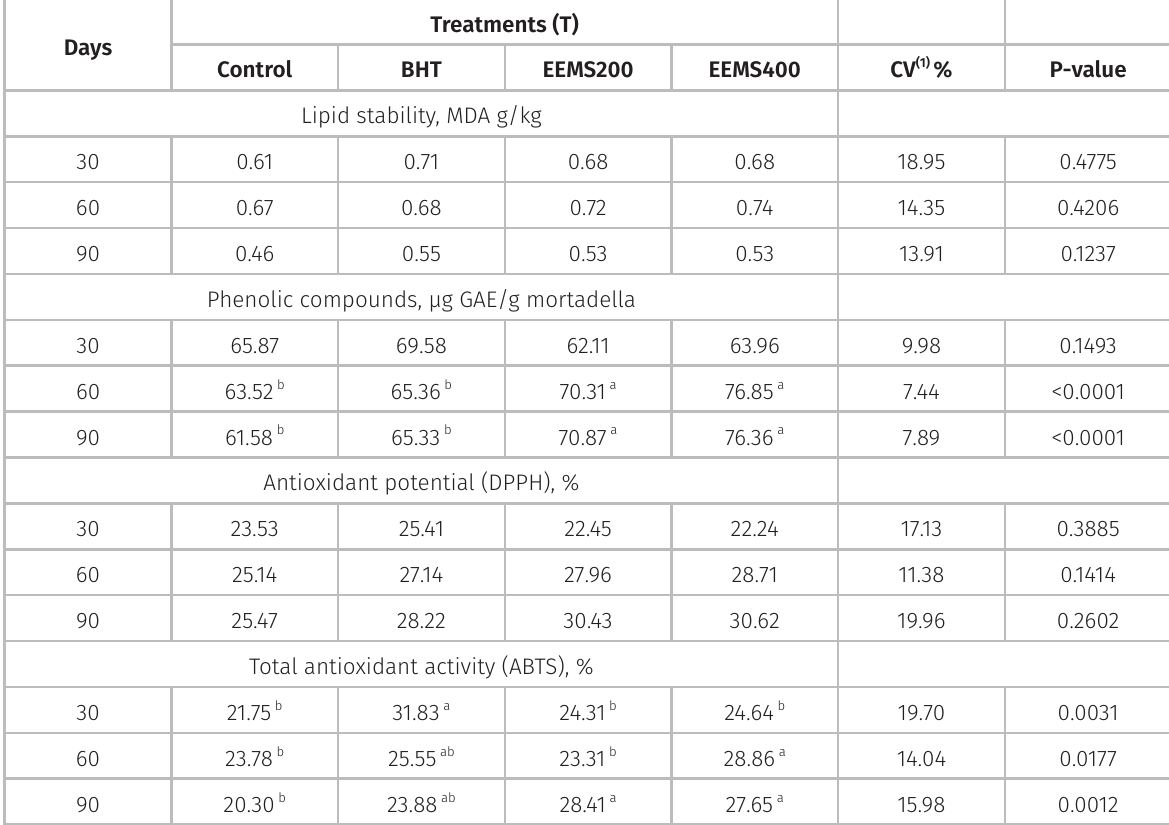
Table IV. Lipid stability, total phenolic compounds, potential and total antioxidant activity of mortadella prepared with pork meat fed with diets containing BHT and EEMS stored under refrigeration at 4 °C for 90